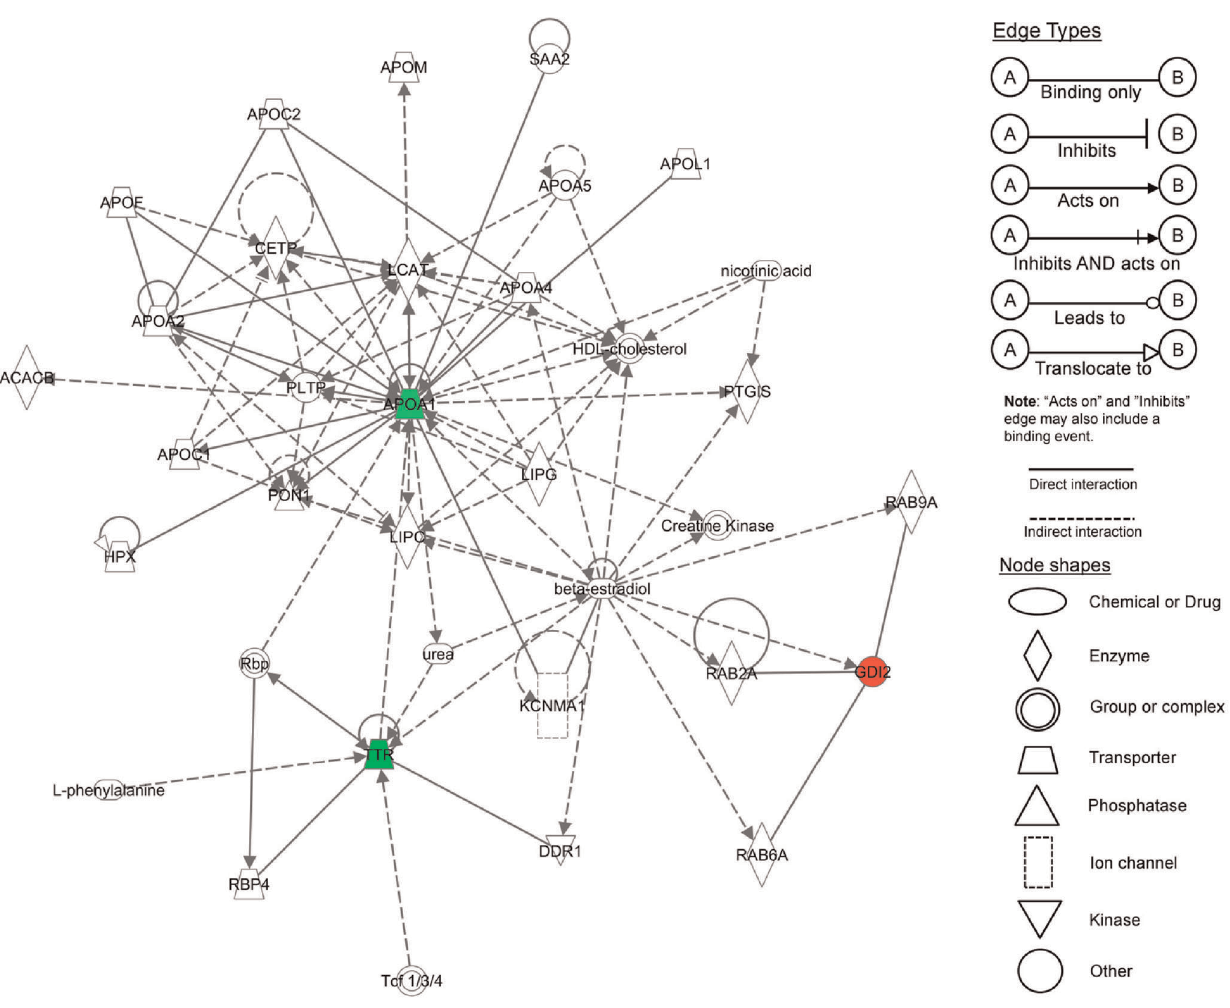
Figure 3. IPA graphical representation of the molecular relationships between differentially expressed proteins in HepG2 cells treated with T.indica extract. The network is displayed graphically as nodes (proteins) and edges (the biological relationships between the nodes). Nodes in red indicate up-regulated proteins while those in green represent down-regulated proteins. Nodes without colors indicate unaltered expression. Various shapes of the nodes represent the functional class of the proteins. The different arrow shapes represent different types of interactions. Edges are displayed with various labels that describe the nature of the relationship between the nodes. Names of proteins corresponding to the abbreviations are as follows: APOA1, Apolipoprotein A-1; APOA2, Apolipoprotein A-2; APOA4, Apolipoprotein A-4; APOA5, Apolipoprotein A-5; APOC1, Apolipoprotein C-1; APOC2, Apolipoprotein C-2; APOE, Apolipoprotein E; APOM, Apolipoprotein M; APOL1, Apolipoprotein L-1; ACACB, acetyl-CoA-carboxylase 2; SAA2, serum amyloid A2; LCAT, lecithin cholesterol acyltransferase; PLTP, phospholipid transfer protein; CETP, cholesterylester transfer protein; PTGIS, prostaglandin I synthase; RAB9A, Ras-related protein Rab 9A; RAB6A, Ras-related protein Rab 6A; GDI2, Rab GDP dissociation inhibitor beta; RAB2A, Ras-related protein Rab 2A; KCNMA1, Potassium large conductance calcium-activated channel, subfamily M, alpha member 1; DDR1, discoidin domain receptor tyrosine kinase 1; TTR, transthyretin; RBP4, retinol binding protein 4; LIPC, hepatic triglyceride lipase; LIPG, endothelial lipase; PON1, paraoxonase 1; HPX, haemopexin; Tcf 1/2/3, T-cell factor -1, -2, -3; Rbp, retinol binding